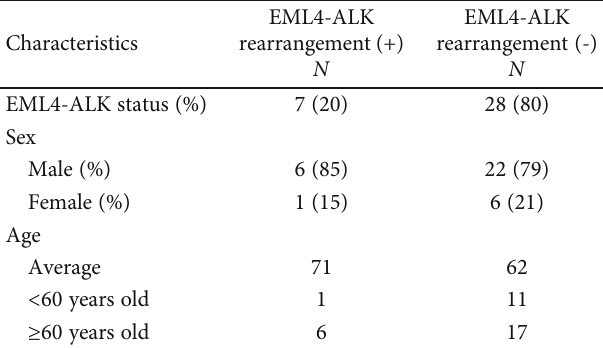
Table 2: EML4-ALK rearrangement